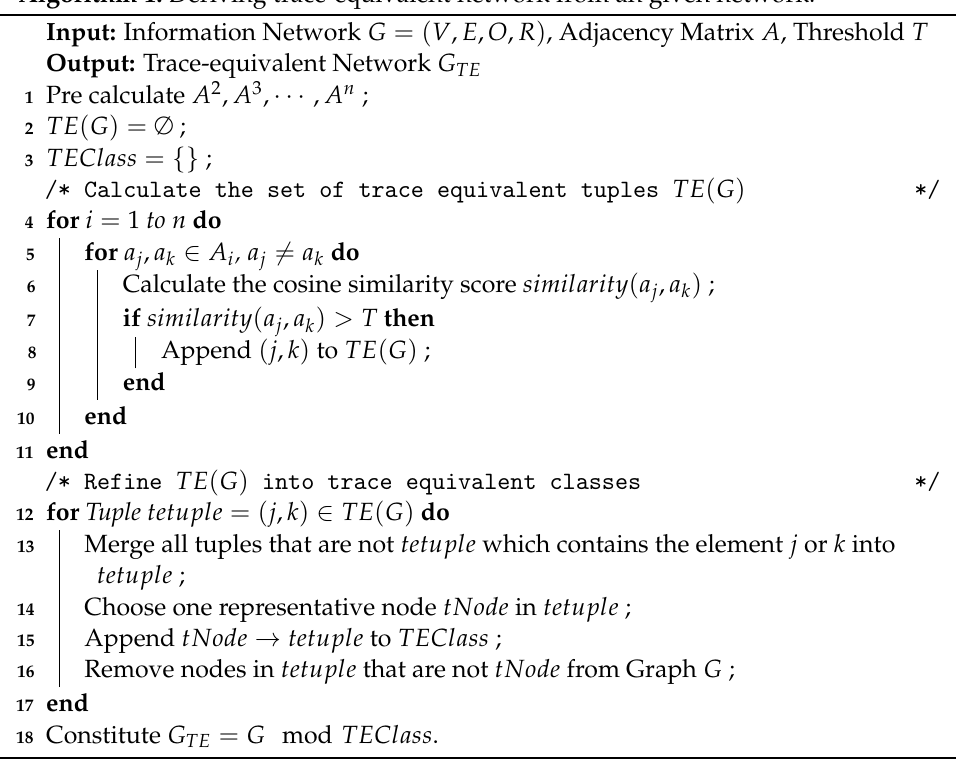
Algorithm 1: Deriving trace-equivalent network from an given